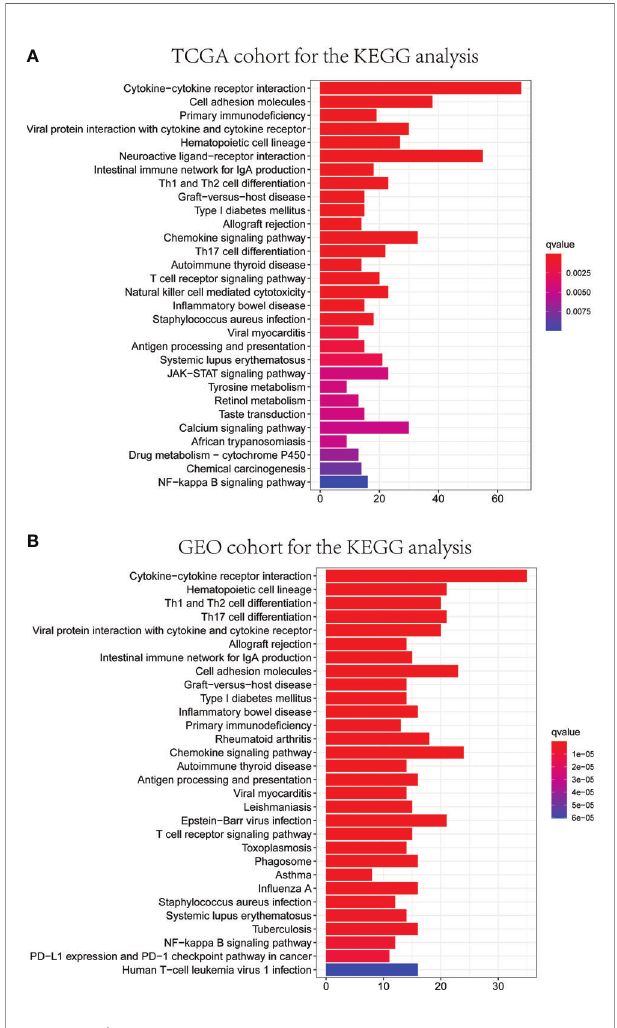
FIGURE 8 | Representative results of KEGG enrichment analysis in TCGA and GEO databases. The results of KEGG pathway analysis of DEGs between different risk groups in TCGA (A) and GEO (B)